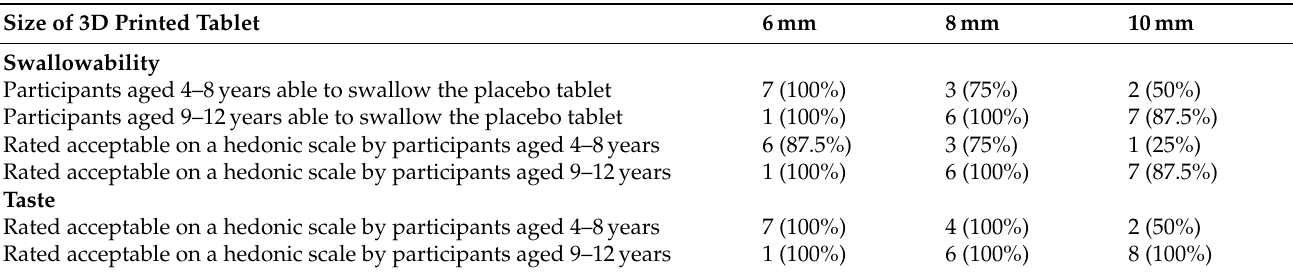
Figure 3. SEM image of a top view of ( A ) film-coated tablets and ( B ) 3D printed tablets. Table 1. Summary of acceptability of 3D printed tablets *